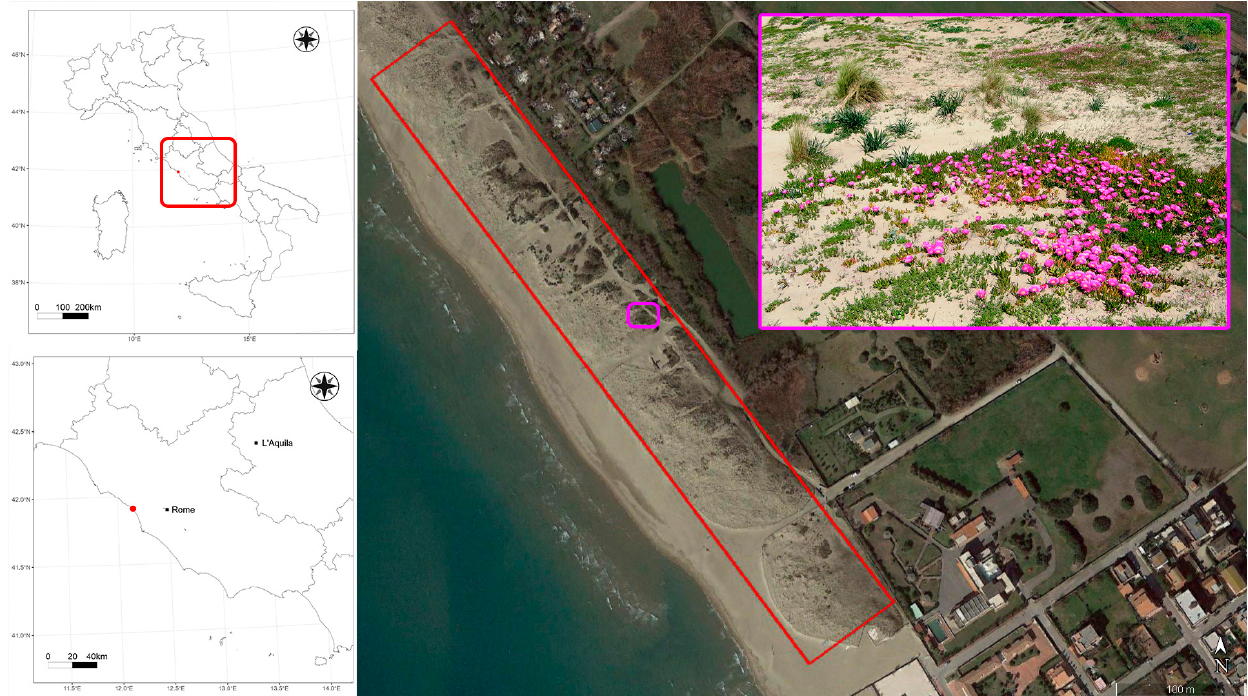
Figure 2. Map of the study area (41.909461°N, 12.148823°E, Passoscuro, Fiumicino, Rome, EPSG:4326-WGS84). The location of the Passoscuro shoreline where the UAV surveys were carried out is shown in the red boxes on the left on a map of Italy and a map of the region Latium where Passoscuro is located. The 5-hectare area surveyed is outlined in red in the central air photo (image acquired in March 2022 © Maxar Technologies and visible on the © Google Earth platform). The top right inset shows detail of the Passoscuro dune, highlighting a Carpobrotus bloom (Picture by Alicia Teresa Rosario Acosta).